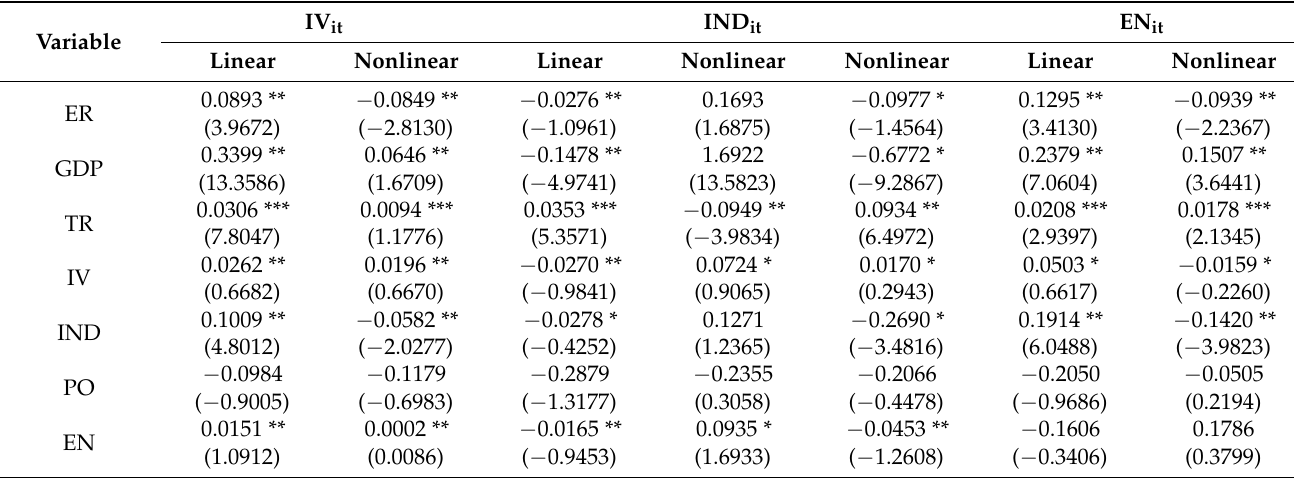
Table 11. Robustness test